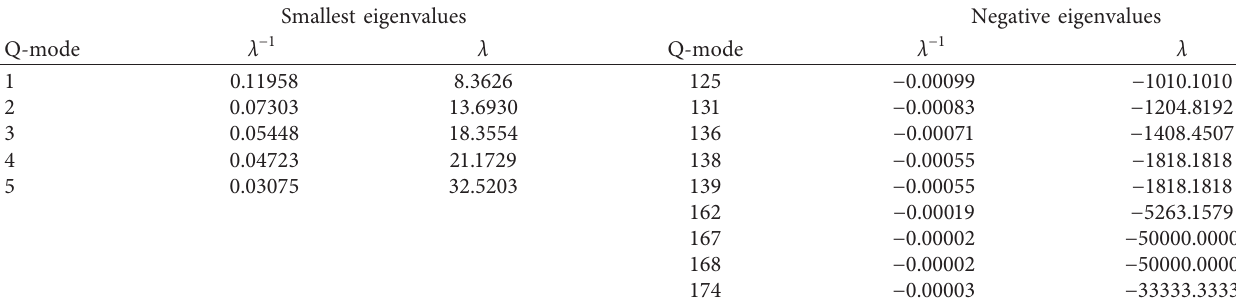
Table 4: Test system eigenvalues.